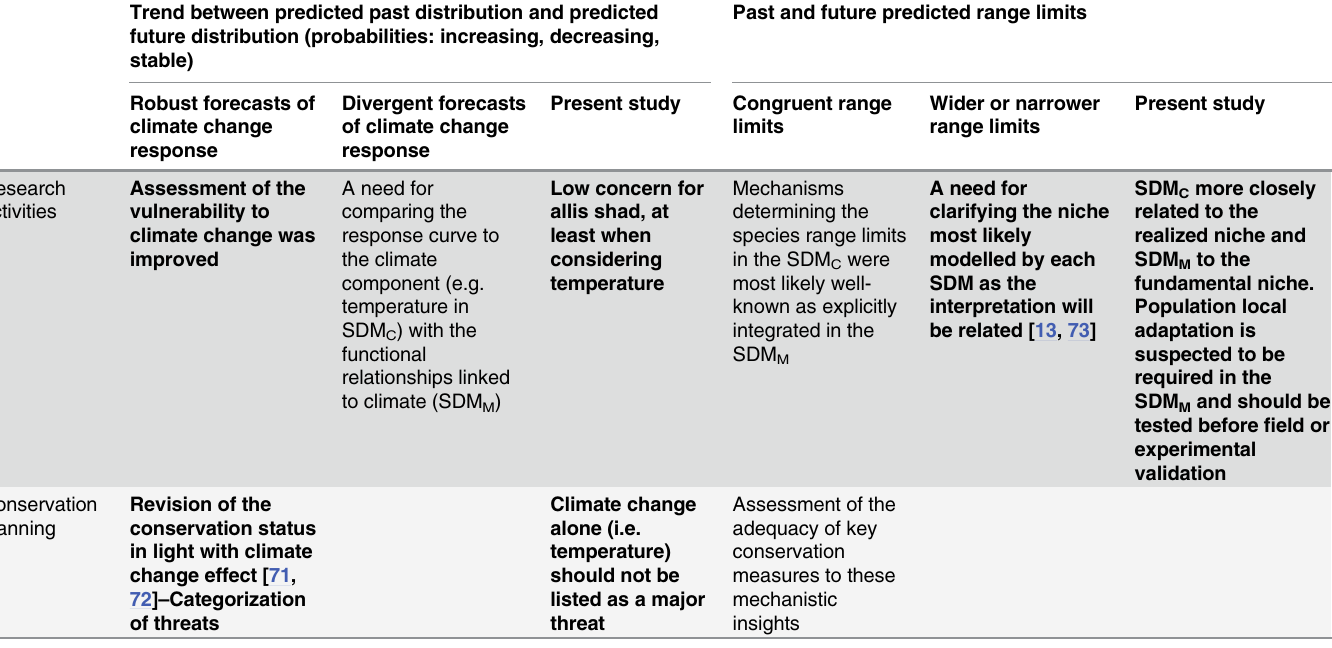
Table 2. Guidelines for interpreting similarities and differences in SDMs outputs in terms of research activities and biological conservation. In bold were given the categories to which the present study was finally assigned. Blank cells signified that preferentially no conservation planning recommen- dations should be drawn. SDM C and SDM M were abbreviations corresponding to the correlative and mechanistic species distribution models, respectively. Trend between predicted past distribution and predicted future distribution (probabilities: increasing, decreasing,